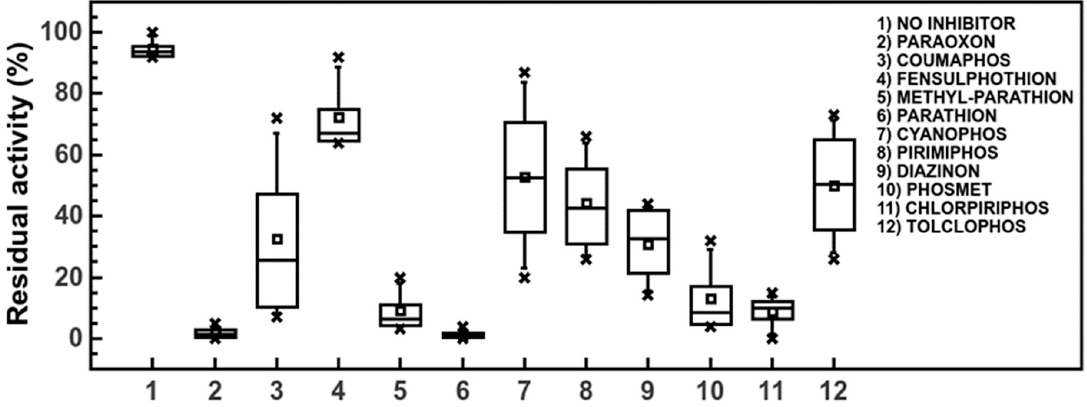
Figure 5. Box-plot of EST2 residual activity in presence of different NBS-oxidized pesticides measured in the range of time from 0 to 9 min by the robotic workstation.